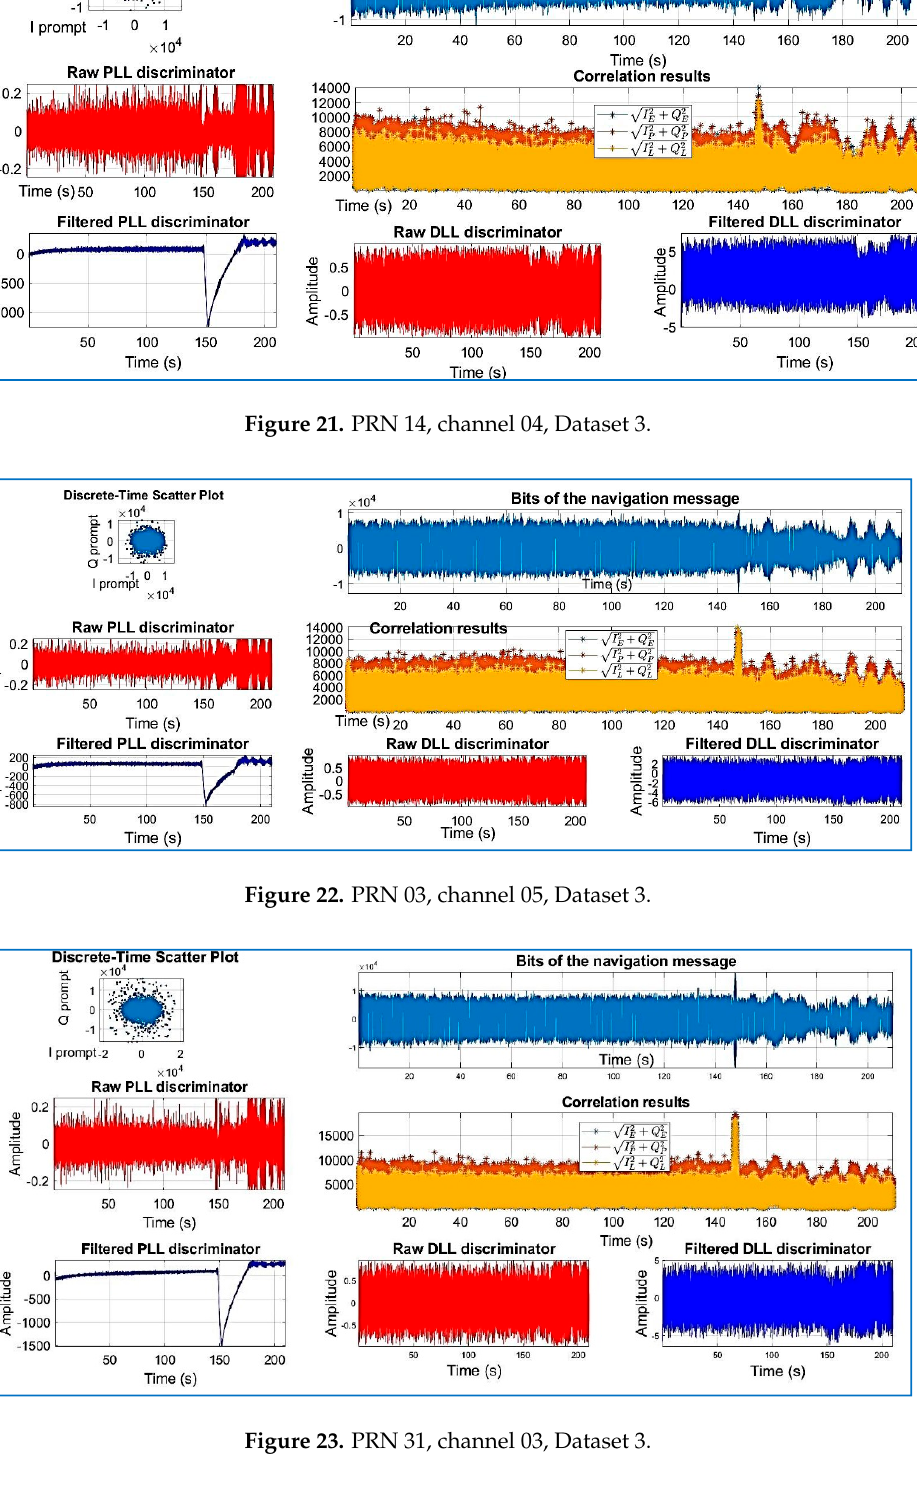
Figure 23. PRN 31, channel 03, Dataset 3.